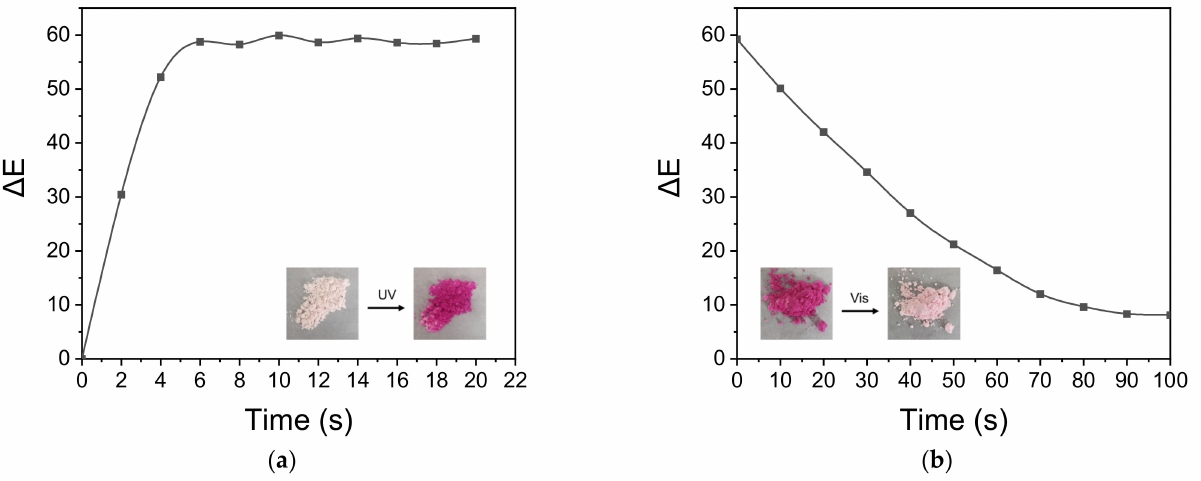
Figure 10. The chromatic aberration ( ∆ E) of the microcapsules under UV irradiation ( a ) and the fading time under visible light ( b